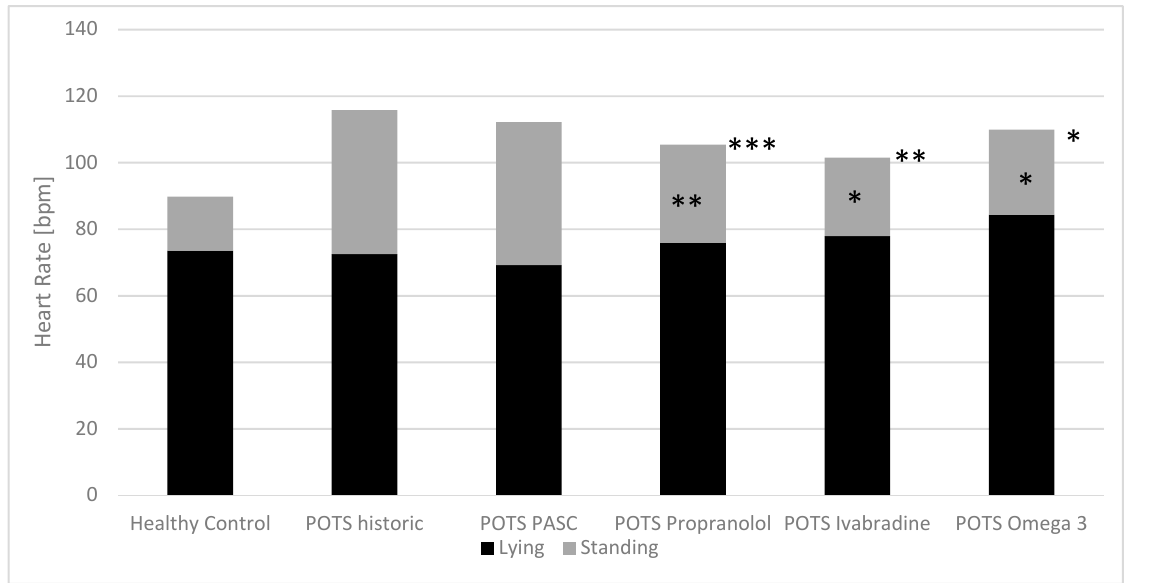
Figure 2. Baseline heart rates in the active standing test and the effect of treatment in children with postural orthostatic tachycardia syndrome. PASC: postacute sequalae of SARS-CoV-2 infection/vaccination; POTS: postural orthostatic tachycardia syndrome. Paired t-test between baseline and treatment: * p -value < 0.05; b ** p -value < 0.01; *** p -value < 0.001.